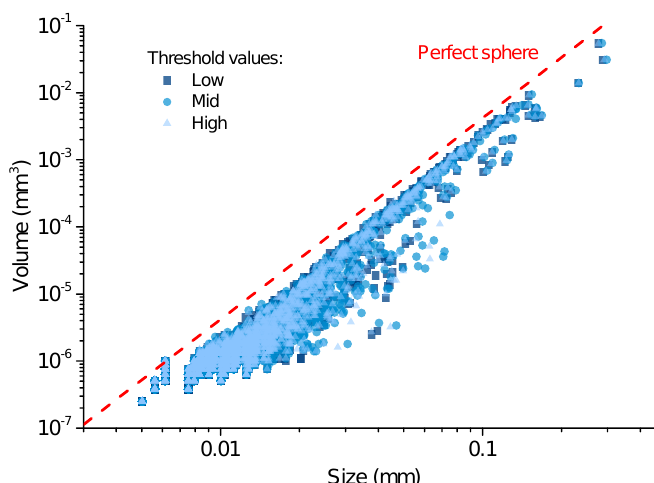
Figure 7. Volume-size distributions of the pores segmented from paste skeleton at low, middle, and high threshold values from Figure